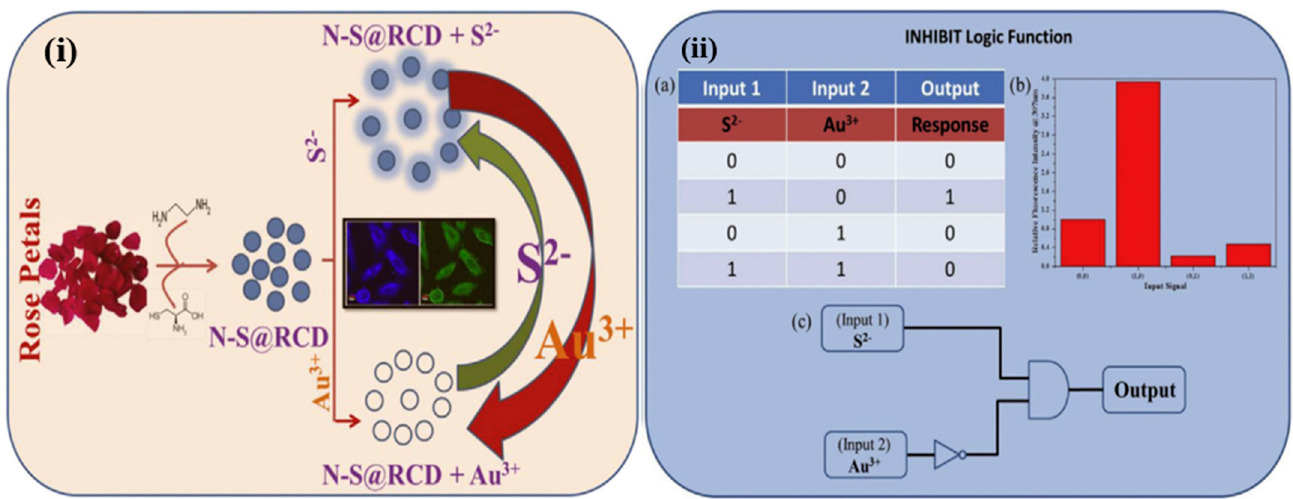
Figure 8. ( i ) Schematic illustration of multifunctional N-S@RCD. ( ii ) “INHIBIT” logic function using N-S@RCD. ( a ) Truth table, ( b ) fluorescence response of N-S@RCD under different inputs, and ( c ) Symbol of INHIBIT logic. Reproduced from ref [73] with permission of the Carbon copyright 2018.